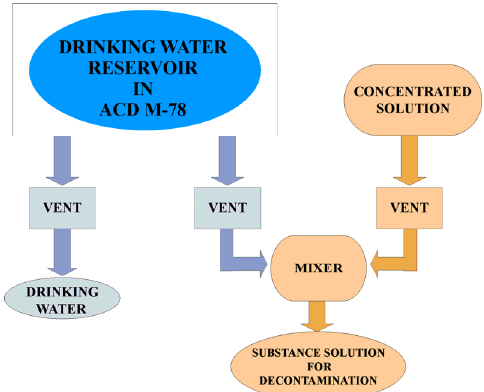
Figure 3 – Graphic representation of the useful functions of the ACD M-78 Рис . 3 – Изображение полезных функий АЦД М -78 Слика 3 – Графички приказ корисних функција АЦД М